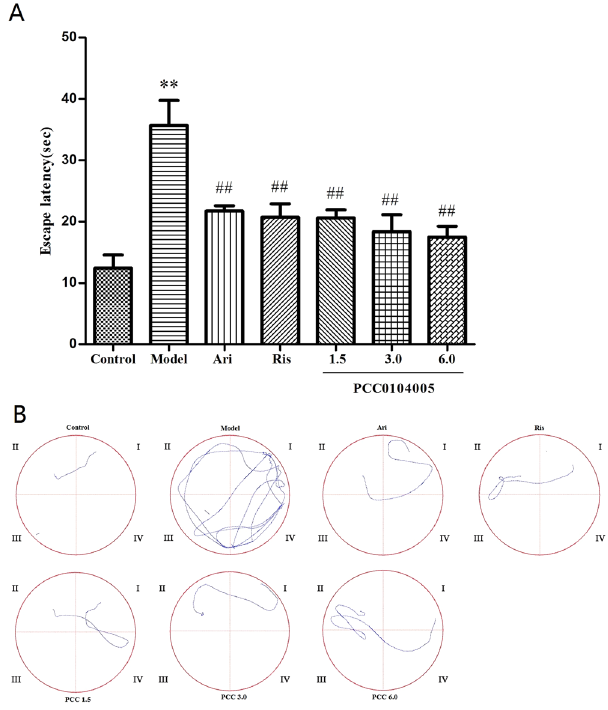
Figure 4. Effects of the acute administration of PCC0104005 on MK-801-treated rats in the MWM test. Rats were administered vehicle alone (0.5% methylcellulose, 1 ml/kg), PCC0104005 (1.5, 3.0, or 6.0 mg/kg), aripiprazole (Ari, 1.5 mg/kg, i.g.) or risperidone (Ris, 0.2 mg/kg) 1 hour before the experiment. Then, all animals were intraperitoneal injections of 0.9% saline or MK-801 (0.2 mg/kg, i.p.) 30 minutes before the test. ( A ) Effects of different drugs on the escape latency of rats. Results are presented as mean ± S.E.M. (n = 8). * P < 0.05, ** P < 0.01 model group vs. the control group, # P < 0.05, ## P < 0.01 drug delivery groups vs. the model group. ( B ) Representative swim paths during the probe